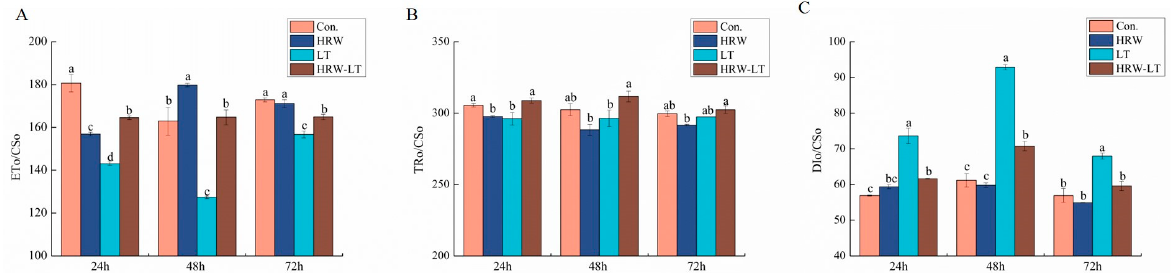
Figure 7. Effect of HRW on energy flow parameters of cucumber seedlings under chilling stress. ( A ) ETo/CSo; ( B ) TRo/CSo; ( C ) DIo/CSo. Data are the mean ± standard deviation of three biological replicates. The different letters indicate a significant difference ( p < 0.05).